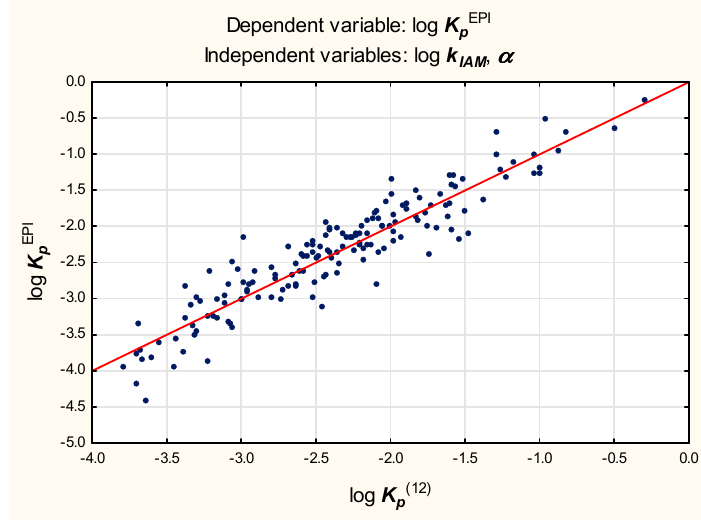
Figure 3. Equation (12)—reference vs. predicted log K p values.